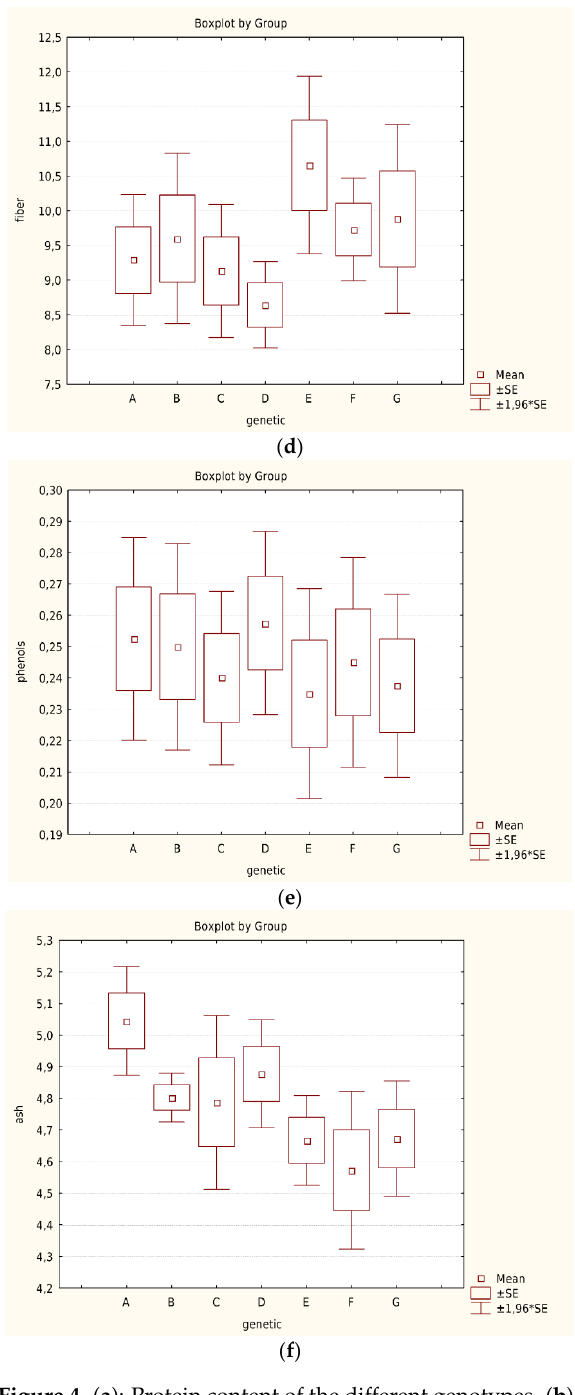
Figure 4. ( a ): Protein content of the different genotypes. ( b ): Starch content of the different genotypes. ( c ): Lipid content of the different genotypes. ( d ): Fiber content of the different genotypes. ( e ): Phenol content of the different genotypes. ( f ): Ash content of the different genotypes.